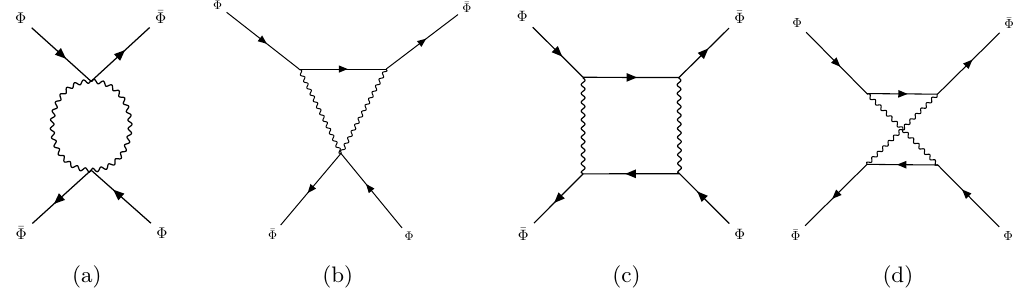
Figure 12 . Feynman supergraphs contributing to the computation of the four-point vertex with only (anti)chiral external